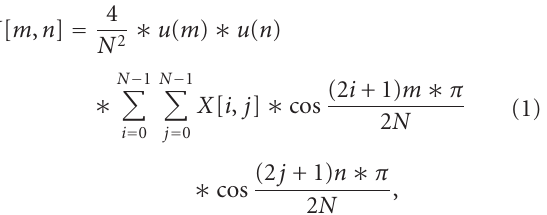
Figure 4: Exemplary butterfly structure for the computation of out- puts y [ · ] based on inputs x [ · ]. The data flow of DCT algorithms can be visualized using such butterfly